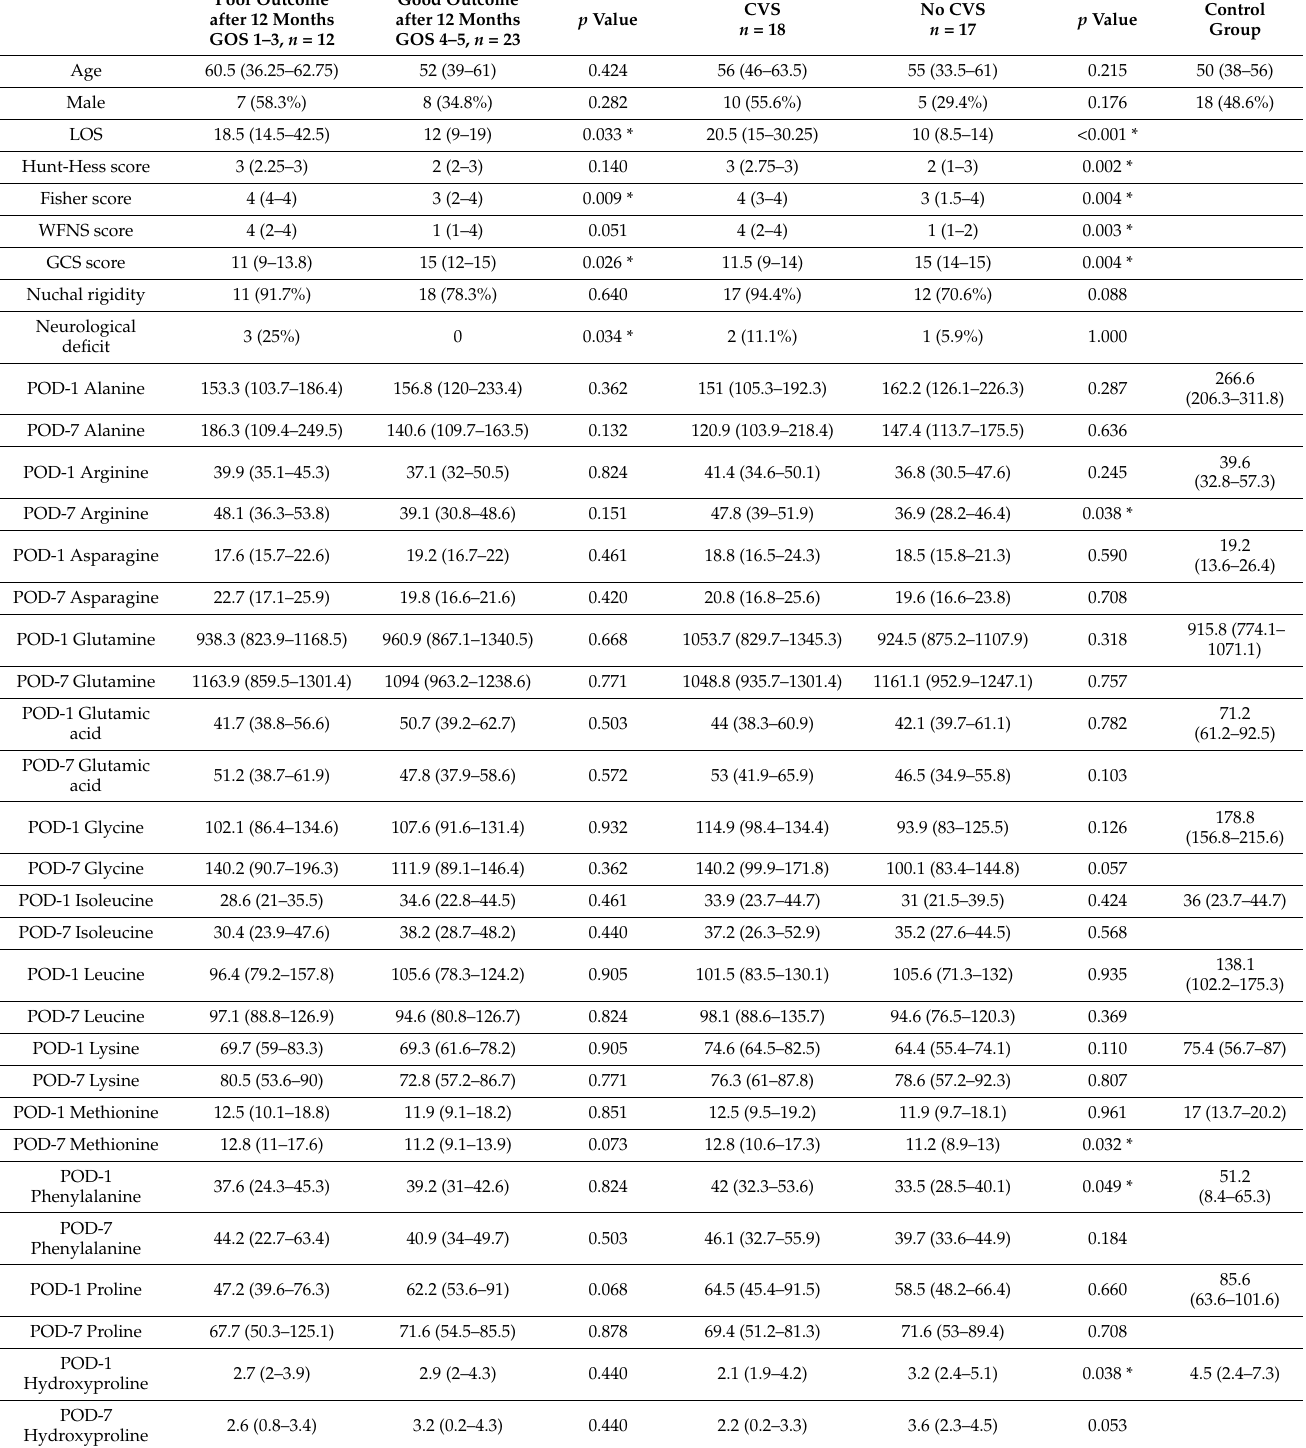
Table 3. Intergroup differences analysis of data of 35 patients after aneurysmal subarachnoid hemor- rhage. Blood samples were collected on post-operative day 1 and 7. All concentrations are given in nmol/mL, and were averaged based on two measurements. * For all tests, p < 0.05 was deemed to be